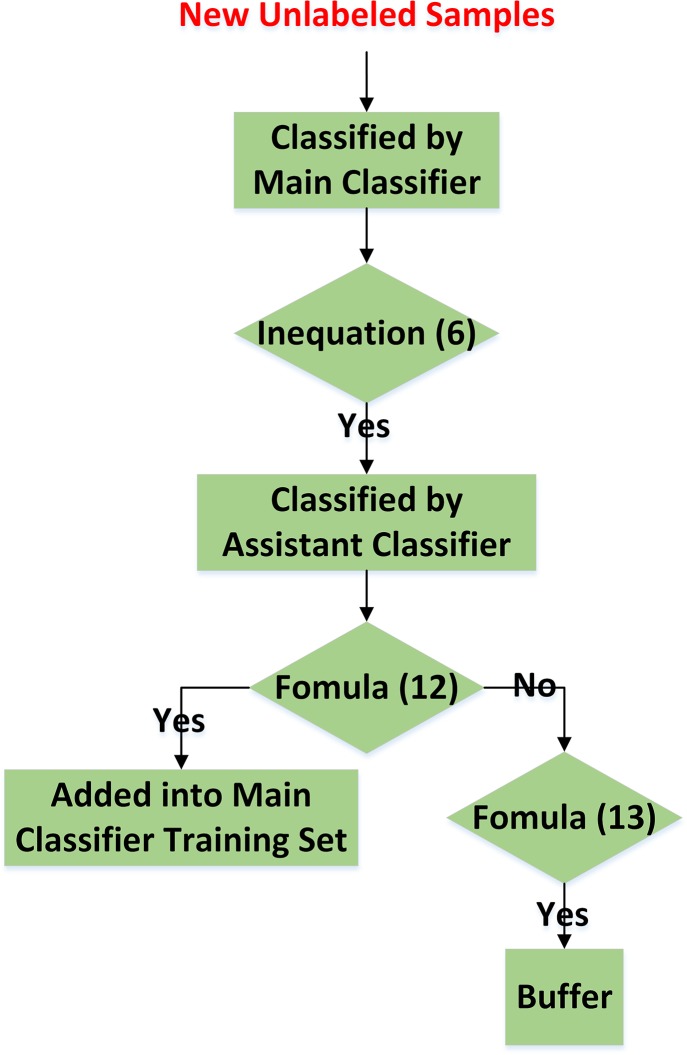
Flow-chart of “soft-start.”